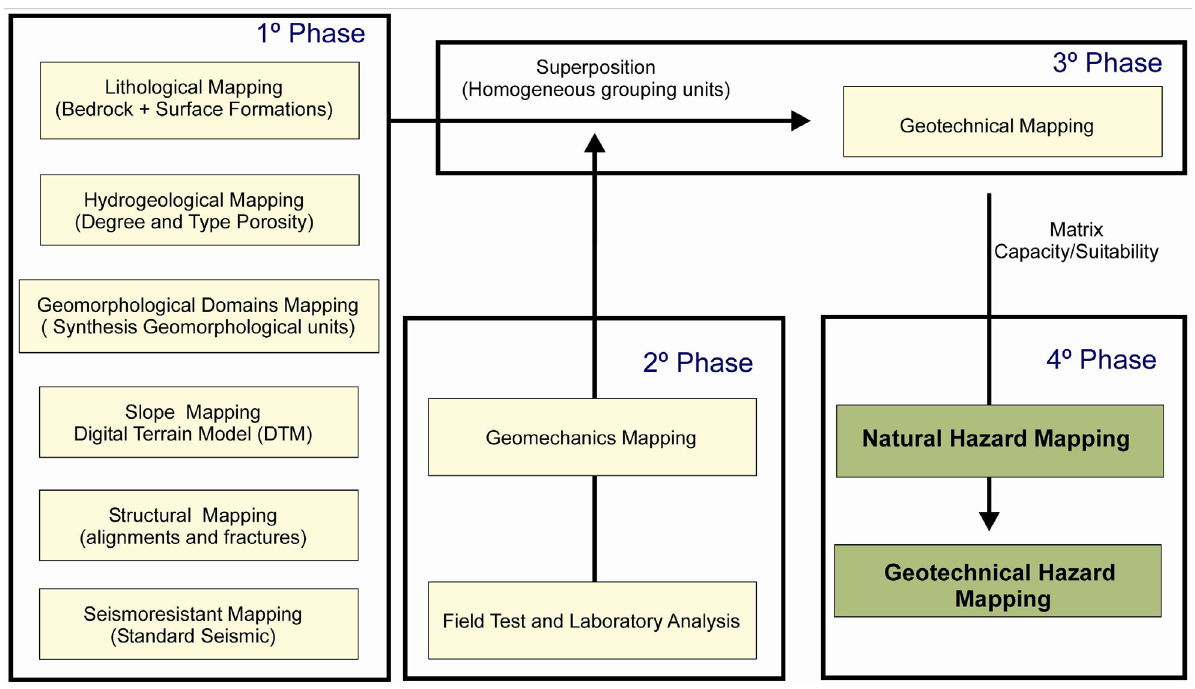
Figure 2. Methodological scheme for the production of the natural hazard cartography and geotechnical hazard